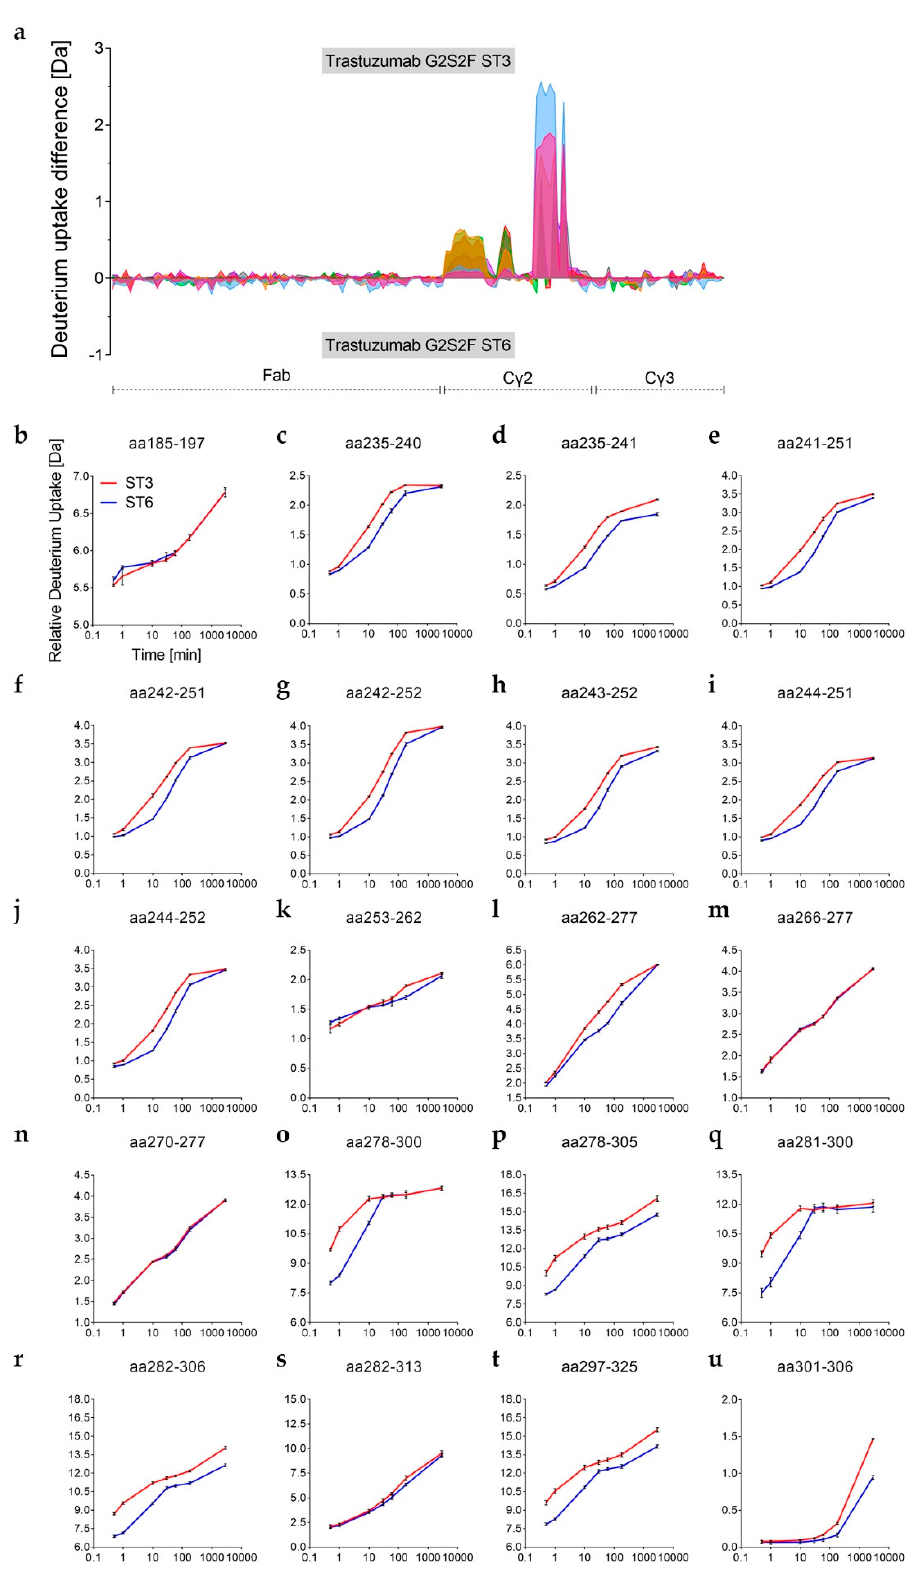
Figure 5. D uptake (Da) of differentially sialylated trastuzumab glycan variants ( n = 3). Shown are heavy chain peptides, as obtained by pepsin/type XIII digestion (sequence coverage 88%). ( a ) Uptake difference plot of H/DX time course experiment performed for 0.5 min (pink), 1 min (light blue), 10 min (orange), 30 min (green), 1 h (red), 3 h (purple), and 48 h (black). ( b – u ) Relative uptake curves of individual peptides, as summarized in ( a ).